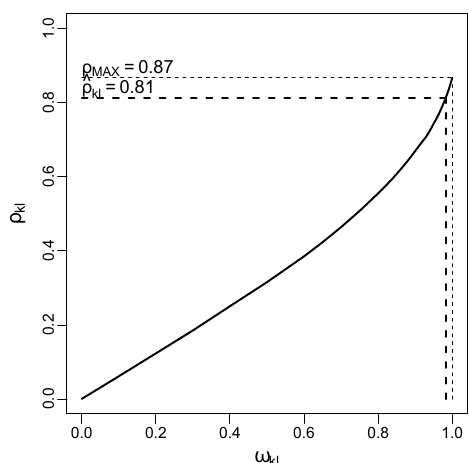
Figure 2. Illustration of the relationship between ω kl and ρ kl for the month of July and for stations GOS and ANT. A Markov chain of order 4 is considered in this example. The correlation be- tween the observed states is ˆ ρ kl = 0 . 81 and can be reproduced us- ing a bivariate Gaussian distribution with a correlation parameter of ω kl = 0 . 98. The maximum correlation ρ which can be obtained if ω kl = 1 is ρ MAX = 0 .